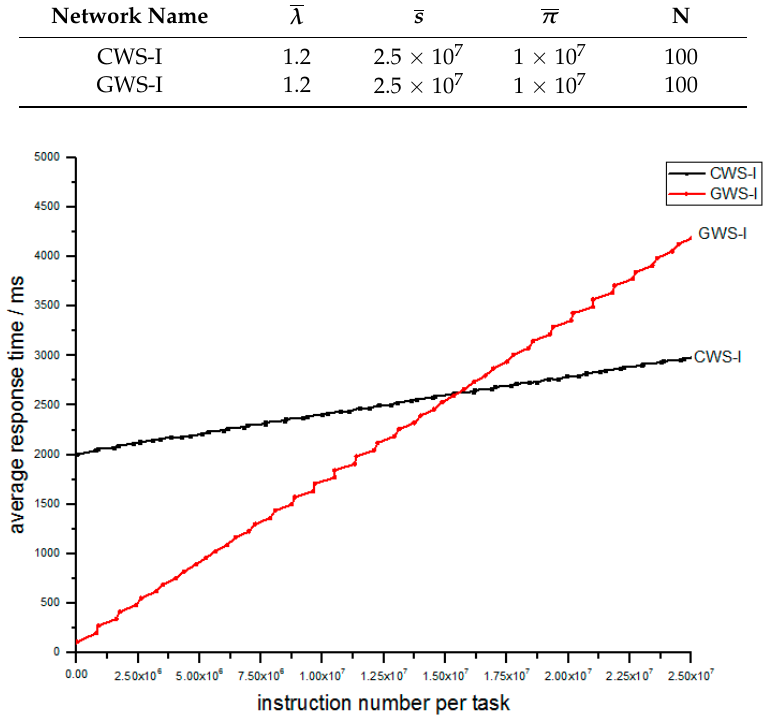
Figure 10. Relation of average response time and number of instructions per task between CWS-I and GWS-I. Table 3. Parameters of Simulation II.